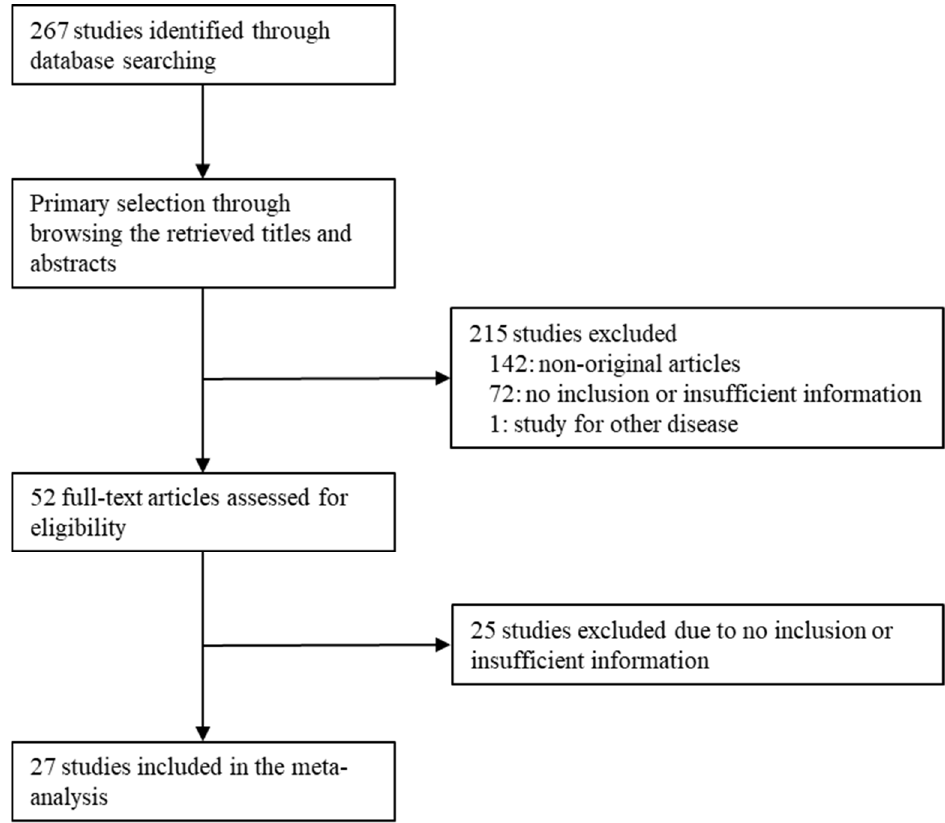
Figure 1. Flow chart of study search and selection methods. Table 1. Main characteristics of eligible studies.